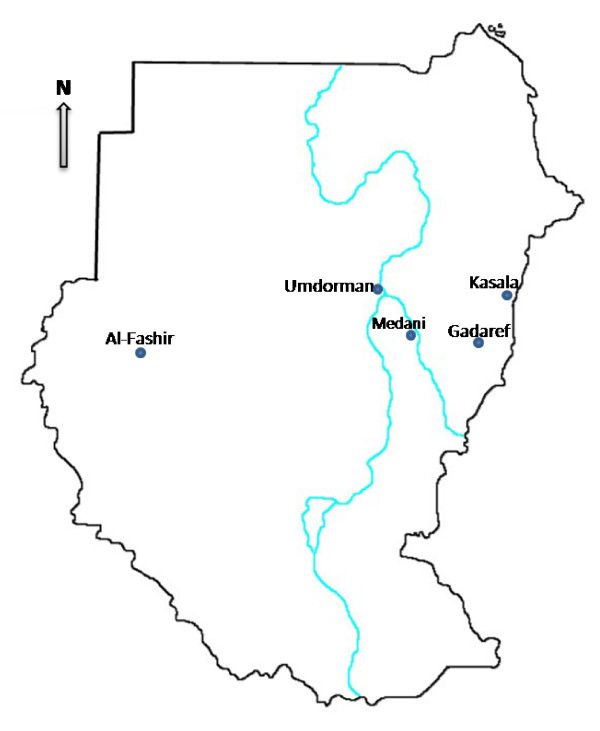
Different regions of Sudan.